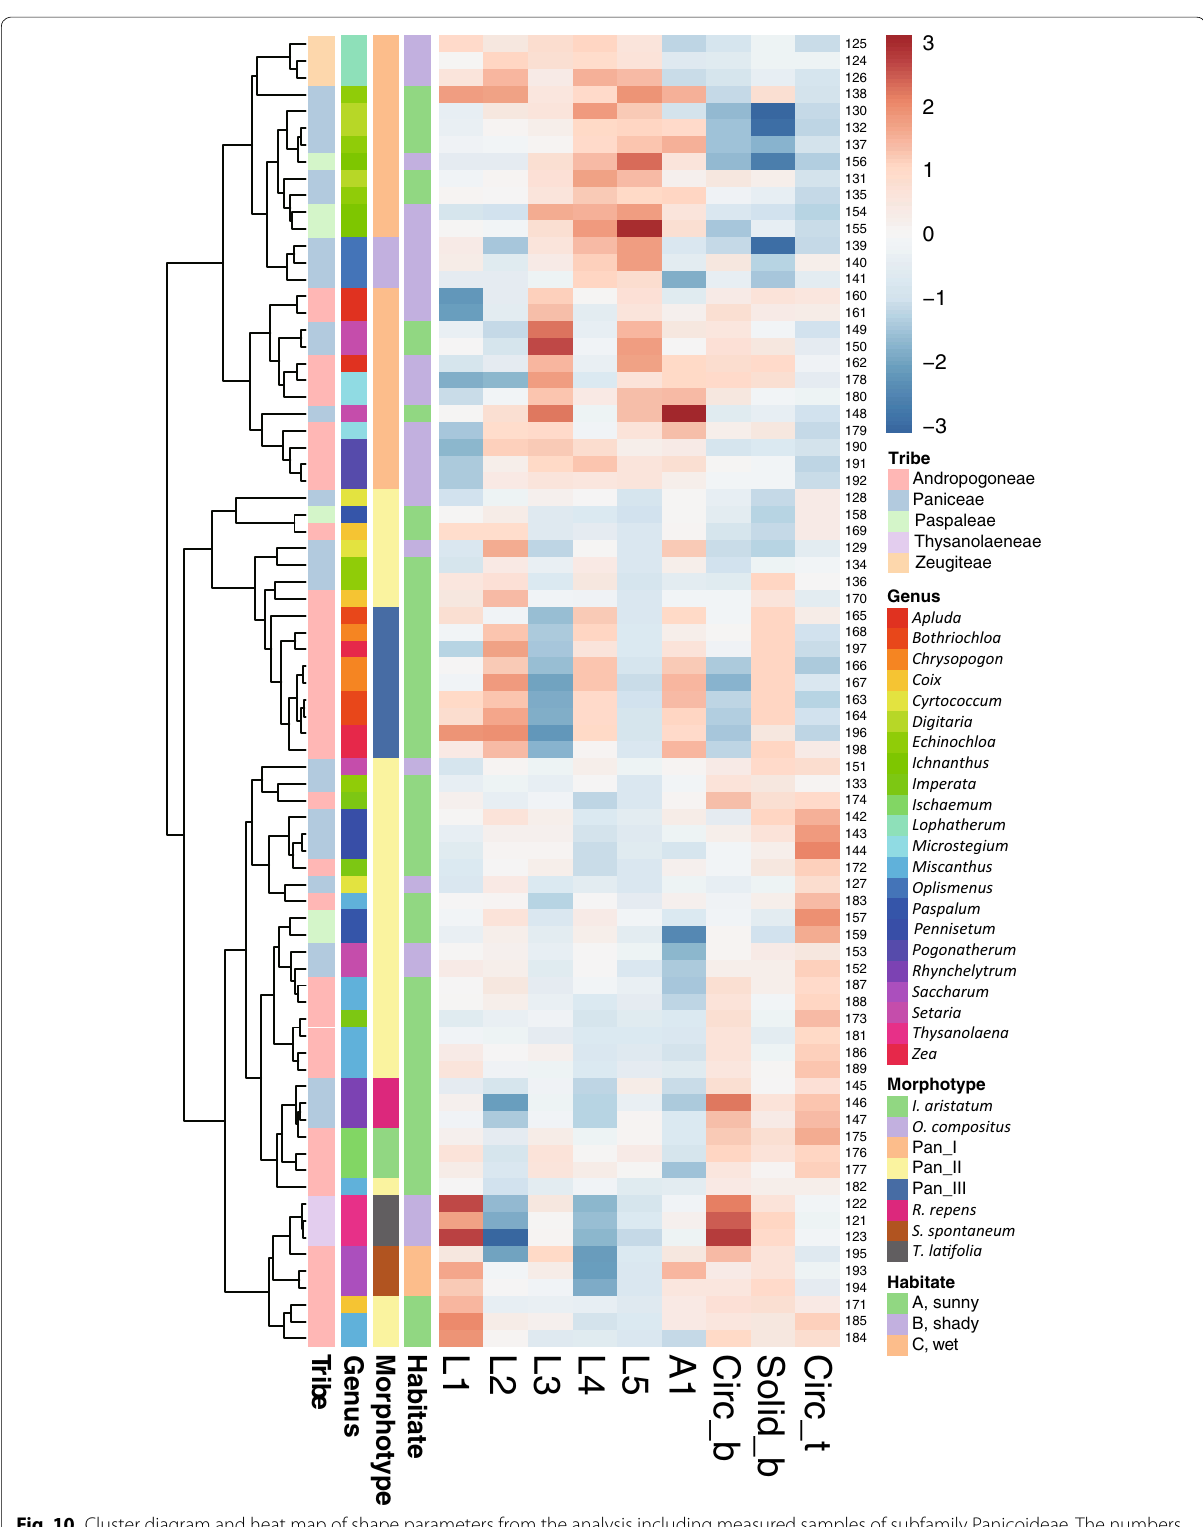
Fig. 10 Cluster diagram and heat map of shape parameters from the analysis including measured samples of subfamily Panicoideae. The numbers are identical to the sample numbers in Table